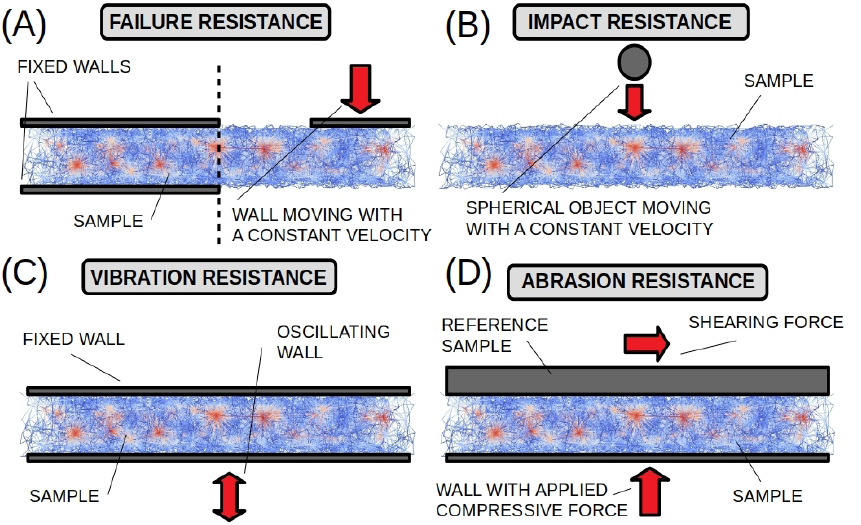
Figure 15: Schematic representation of all four tests: (A) failure resistance test, (B) impact resistance test, (C) vibration resistance test and (D) abrasion resistance test. View of the cross-section of the numerical